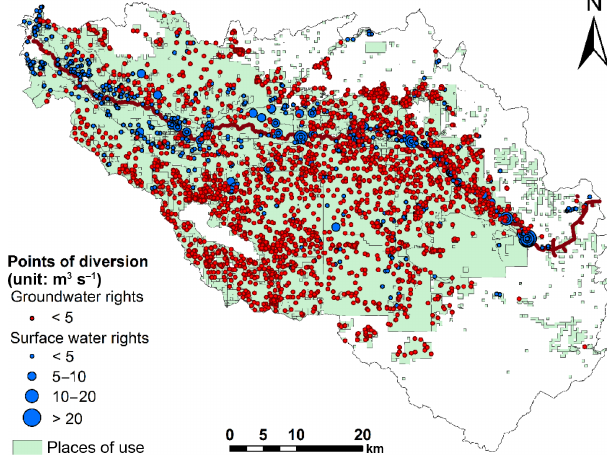
Figure 6. The spatial distribution of the points of diversion (PODs) for irrigation purpose and the maximum allowed diversion